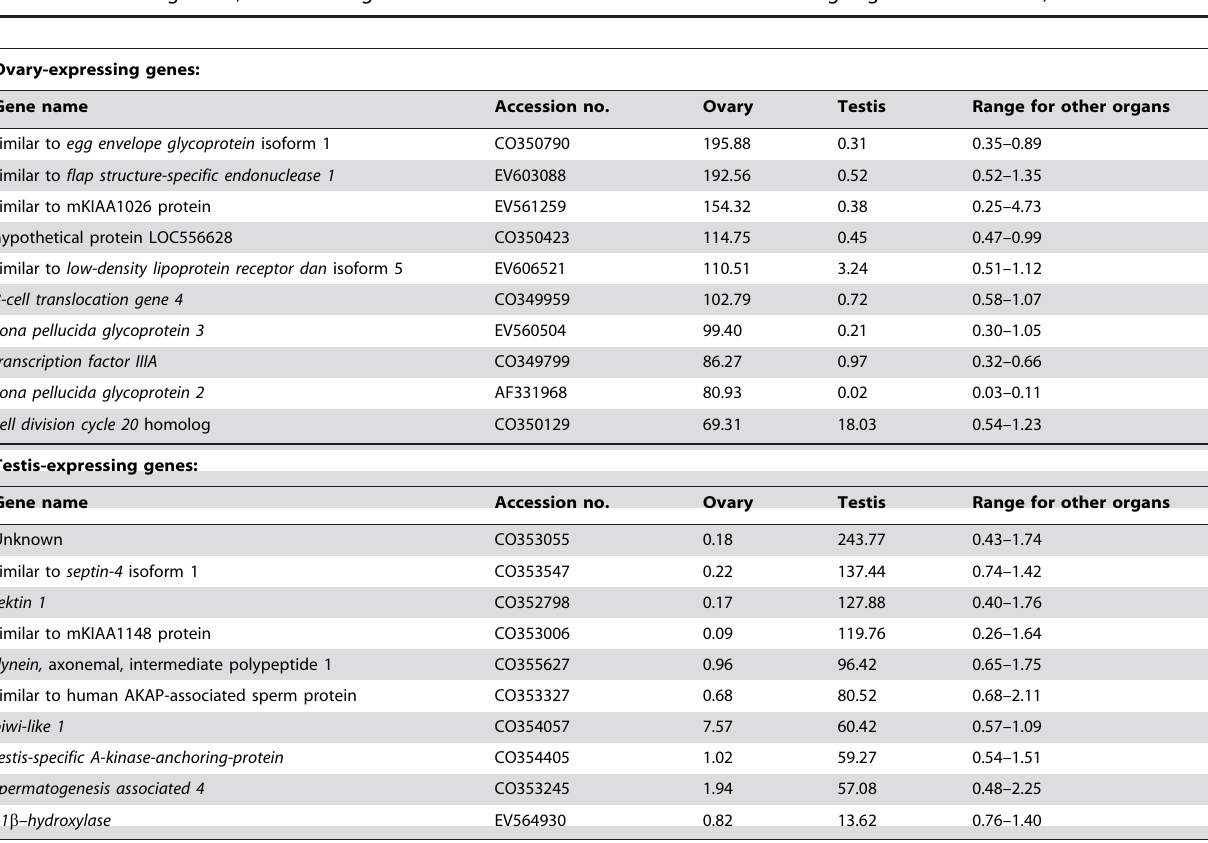
Table 2. Selected genes showing . 1.5-fold higher expression than the common reference in adult zebrafish gonads (normalized intensities for the gonads, and the range of the normalized intensities for the remaining organs are indicated).